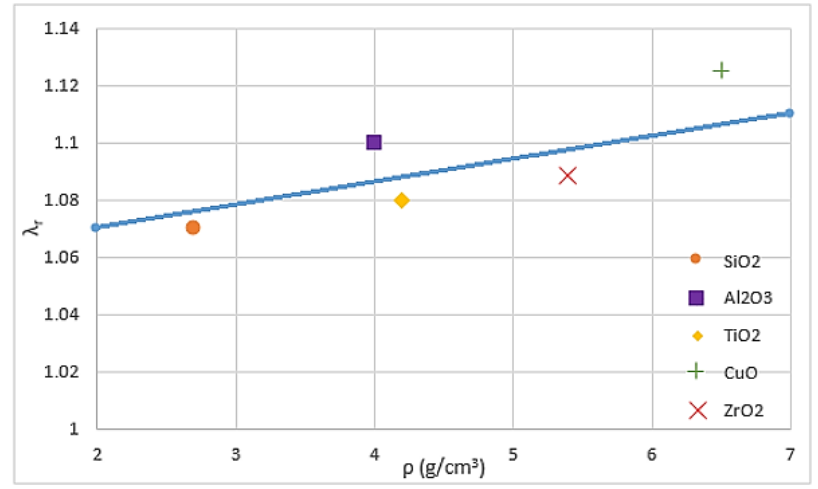
Figure 1. Relative thermal conductivity coefficient versus density of nanoparticles. [59]